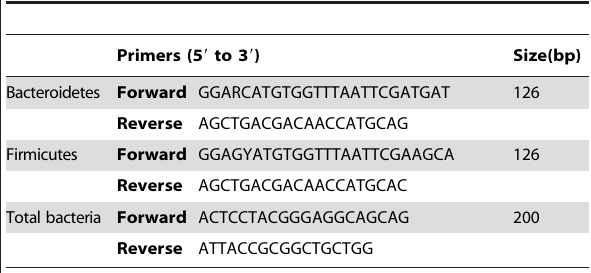
Table 2. Primers for Bacteroidetes, Firmicutes, and total bacteria.